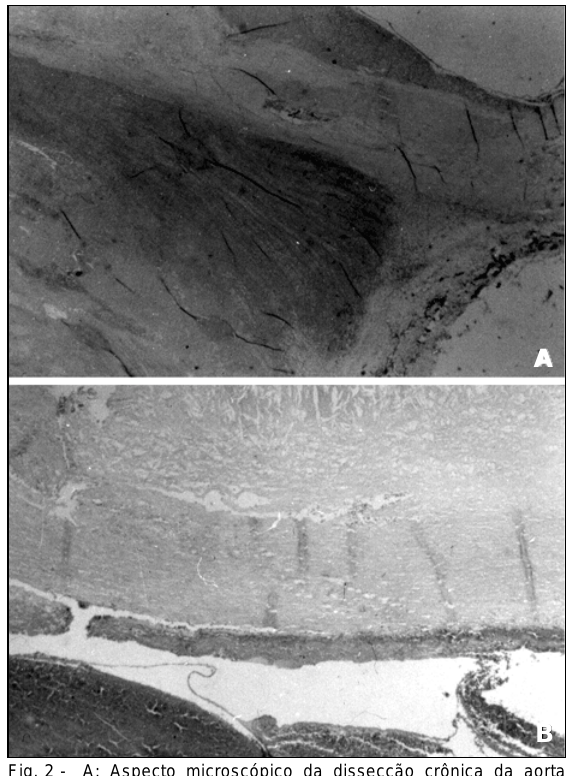
Fig. 2 - A: Aspecto microscópico da dissecção crônica da aorta exibindo trombo em organização na região comprometida. Há trombose recente na superfície da íntima que apresenta espessamento por aterosclerose. B: Aspecto microscópico da dissecção aguda da aorta, podendo-se observar a presen- ça de hematoma recente separando a camada